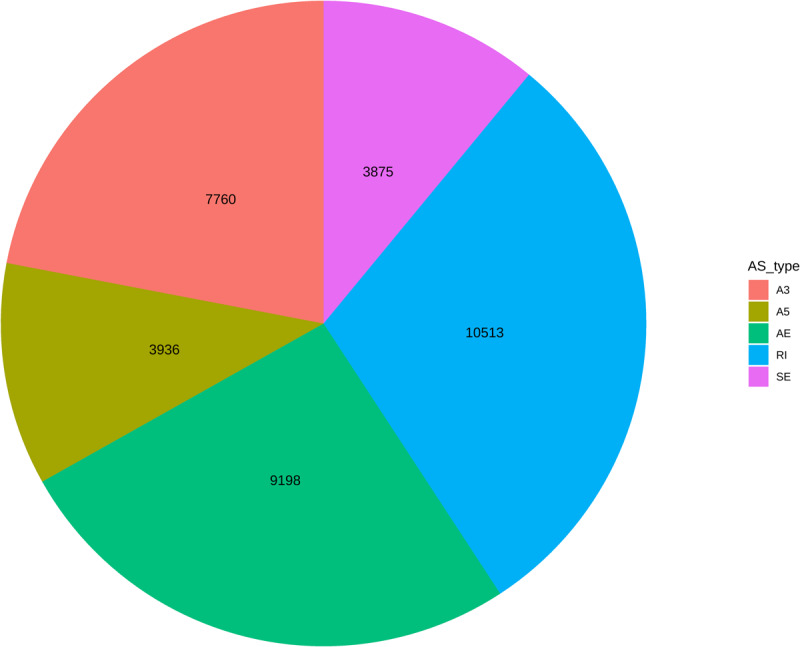
Summary of the abundance of alternative splicing event types. Colors associated with each event type are in the color legend. Abbreviations in legend are defined as: A3, alternative 3′ acceptor sire; A5, alternative 5′ donor site; AE, alternative terminal exon; RI, retained intron; SE, skipped exon.